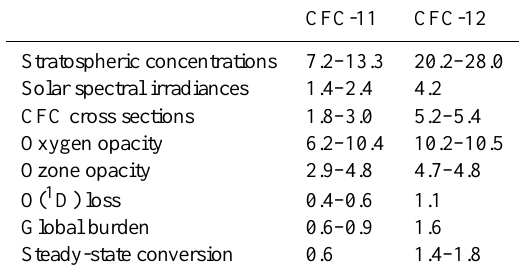
Table A1. Contributions to CFC lifetime uncertainties (yr).